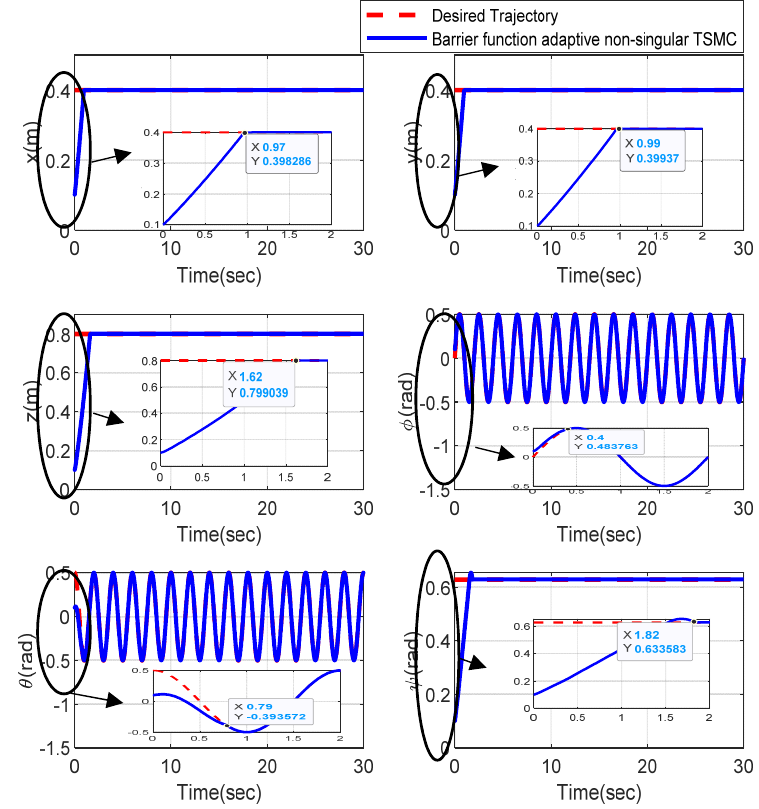
Figure 3. Desired tracking of the quadrotor system.